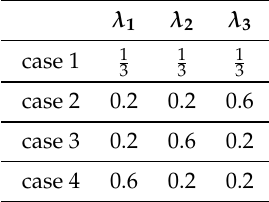
Table 2. Different cases used in simulations.